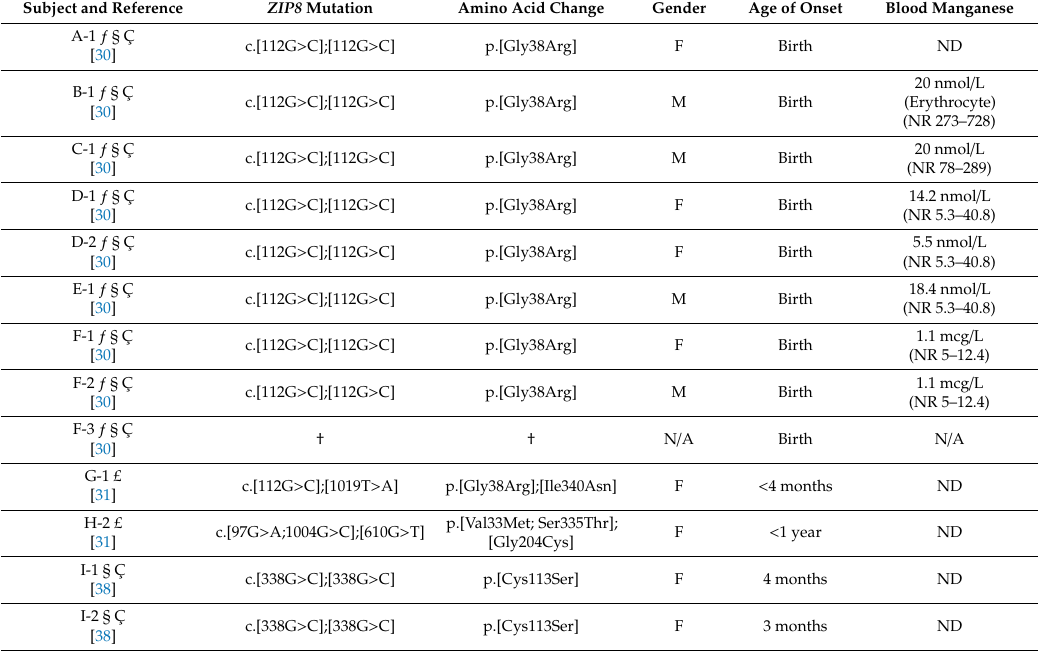
Table 1. Identified human cases of ZIP8